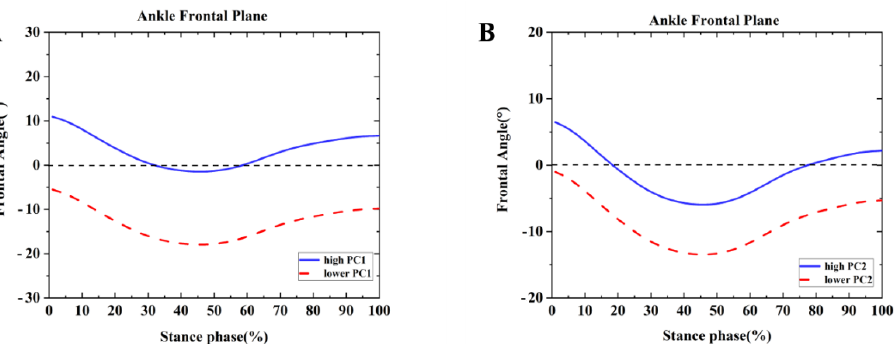
Figure 3. Principal components are retained for the ankle. ( A ) The waveform differences between competitive runners and recreational runners of reconstruction principal using the high and lower PC1-scores in the ankle frontal plane. ( B ) The waveform differences between competitive runners and recreational runners of reconstruction principal using the high and lower PC2-scores in the ankle frontal plane.